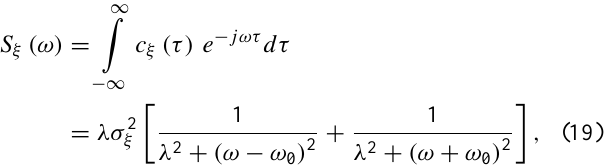
Fig. 4. Comparison of the historical s(t) (red curve) and modelled x(t) (blue curve) annual sunspot number time series in a period 1700–2005. The pulse signal representation can track quite closely the wide range of cycle shapes and amplitudes. Note, however, that some details, like flat maxima, lead to local discrepancies.